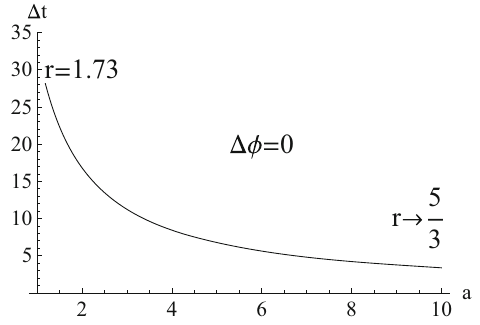
Fig. 23 DependenceoftimeperiodsoftheclosedSPOswith (cid:4)φ = 2 π on the spin parameter a defined for a ∈ ( 1 . 095 , 1 . 155 ).